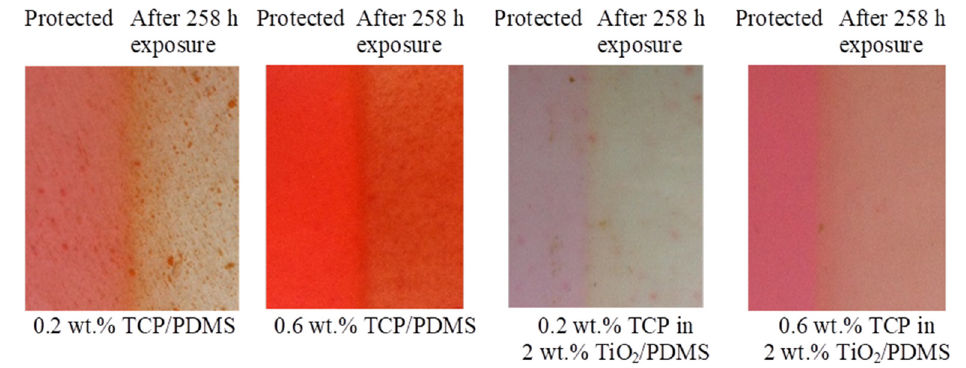
Figure 6. The color change of PDMS and 2 wt% TiO 2 /PDMS nanocomposite specimens colored with TCP (0.2 and 0.6 wt%) after 258 h exposure to accelerated ageing conditions.